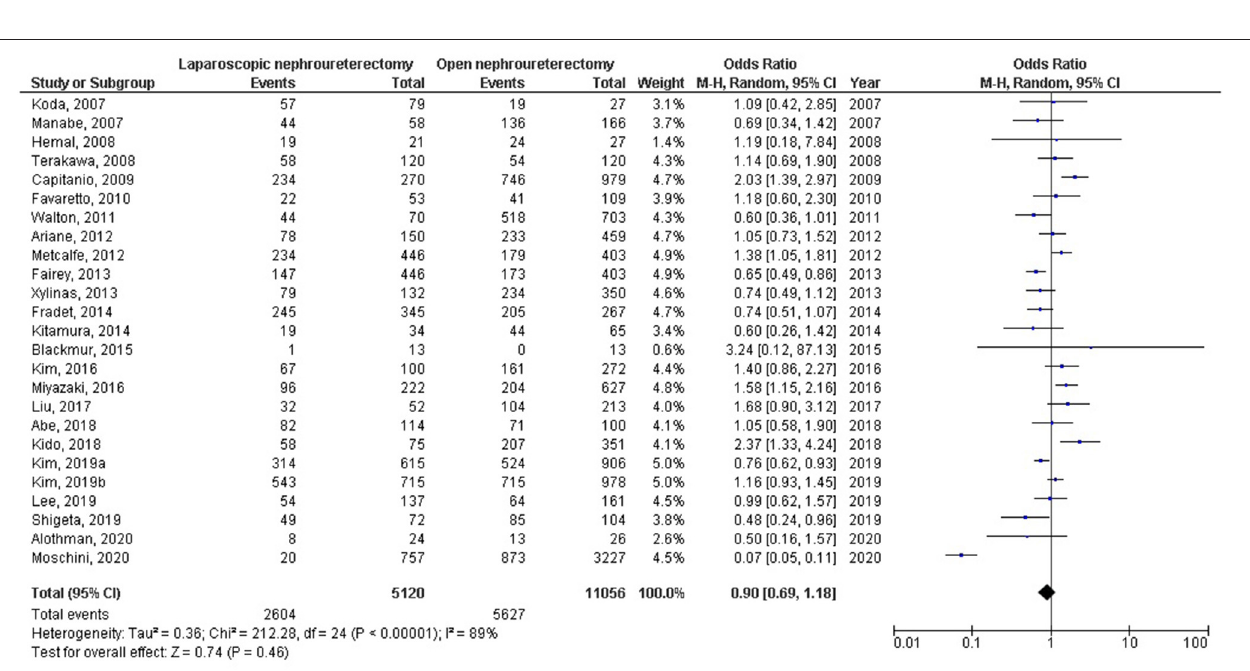
FIGURE 9 | Forest plot of the effect of open nephroureterectomy compared with laparoscopic nephroureterectomy on blood loss in subjects with upper urinary tract urothelial carcinoma.